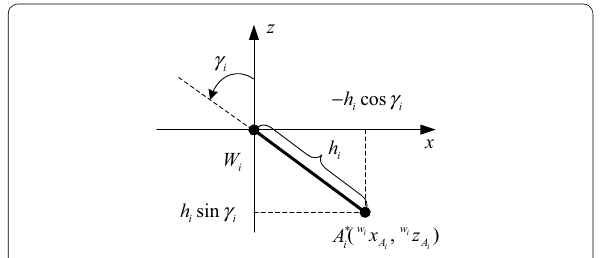
Figure 12 Leg i projection onto xz plane of frame { W i }